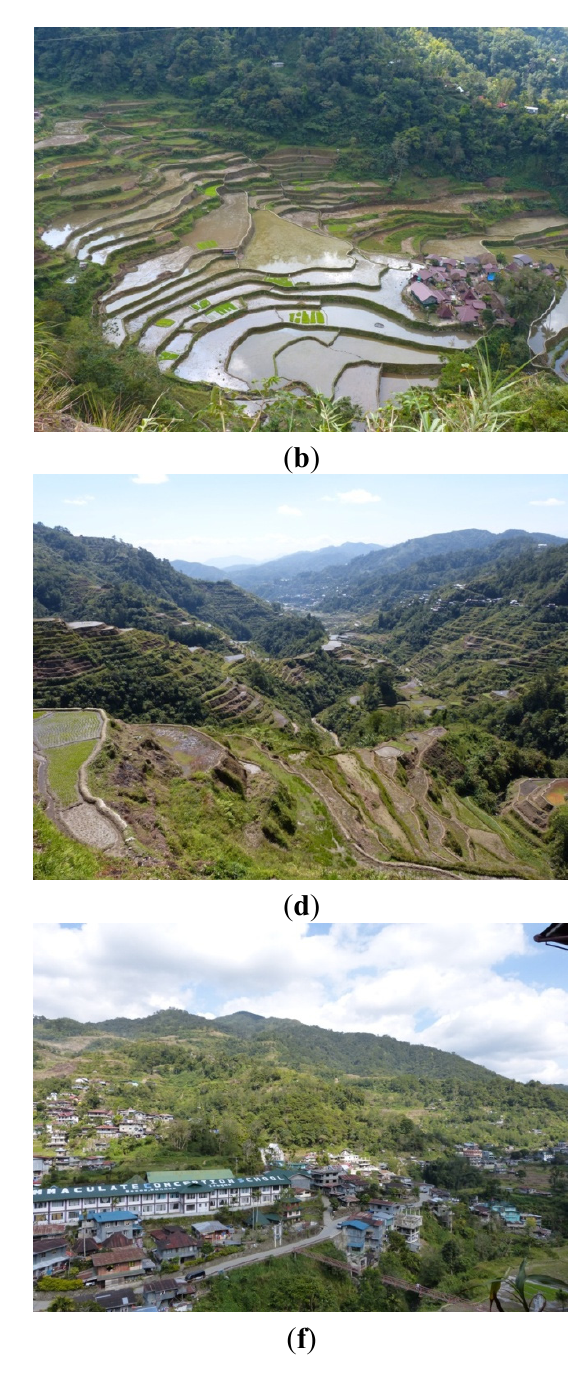
Figure 2. Study sites ( a ) Site 1 Poitan; ( b ) Site 2 Bangaan; ( c ) Site 3 Hingyon; ( d ) Site 4 Banaue Viewpoint; ( e ) Batad; ( f ) Site 6 Banaue (Photo credit: B.